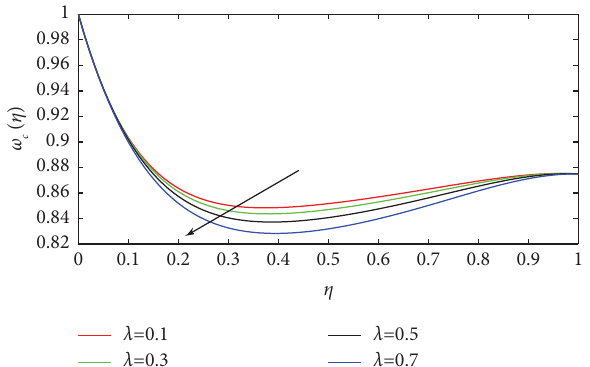
Figure 18: Concentration profles for the diferent values of λ